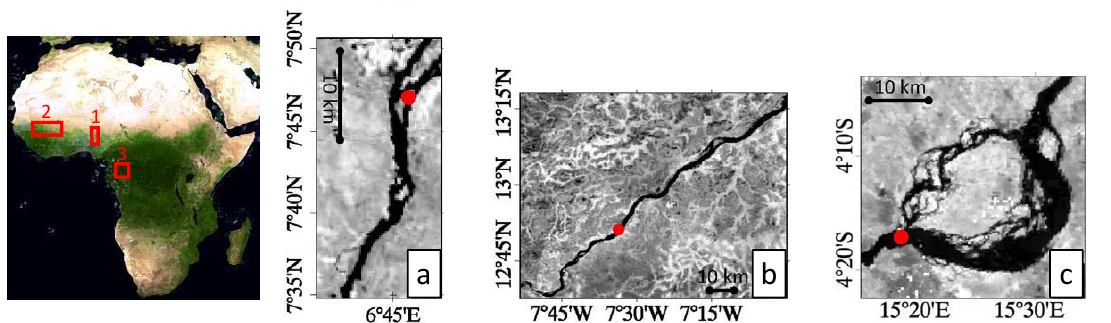
Figure 2. MODIS images of three different river sections selected as case studies. Red dots in each image present the location of the in situ